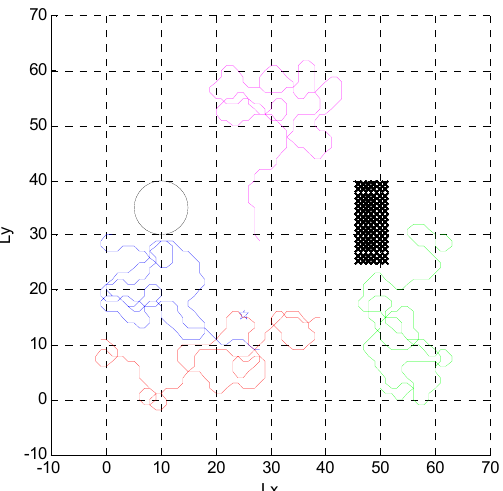
Figure 3. Sea area information learning search.